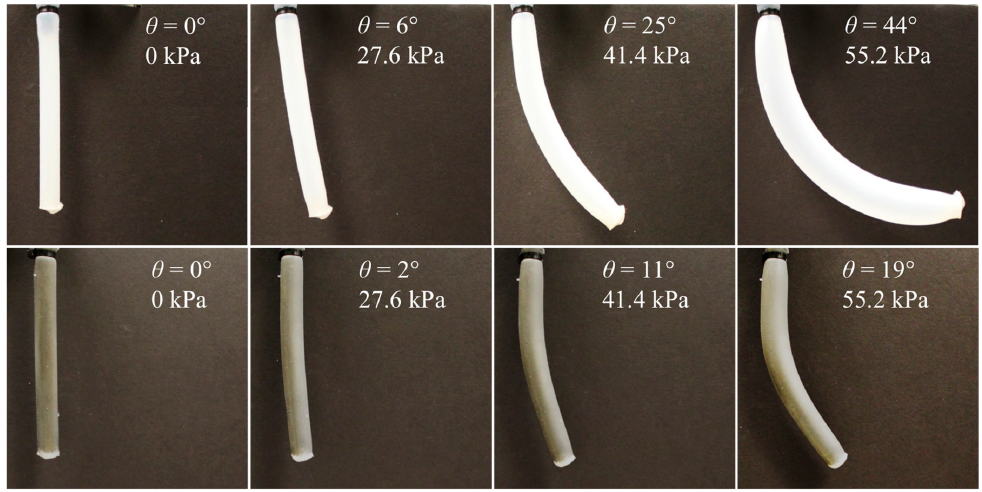
Figure 8. Bending performance test results of soft bilayer actuators with 0.5 wt % ( top ) and 5.0 wt % ( bottom ) nickel particle concentrations.